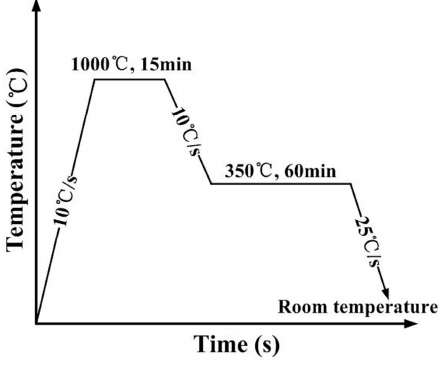
Figure 1. Experimental procedure.